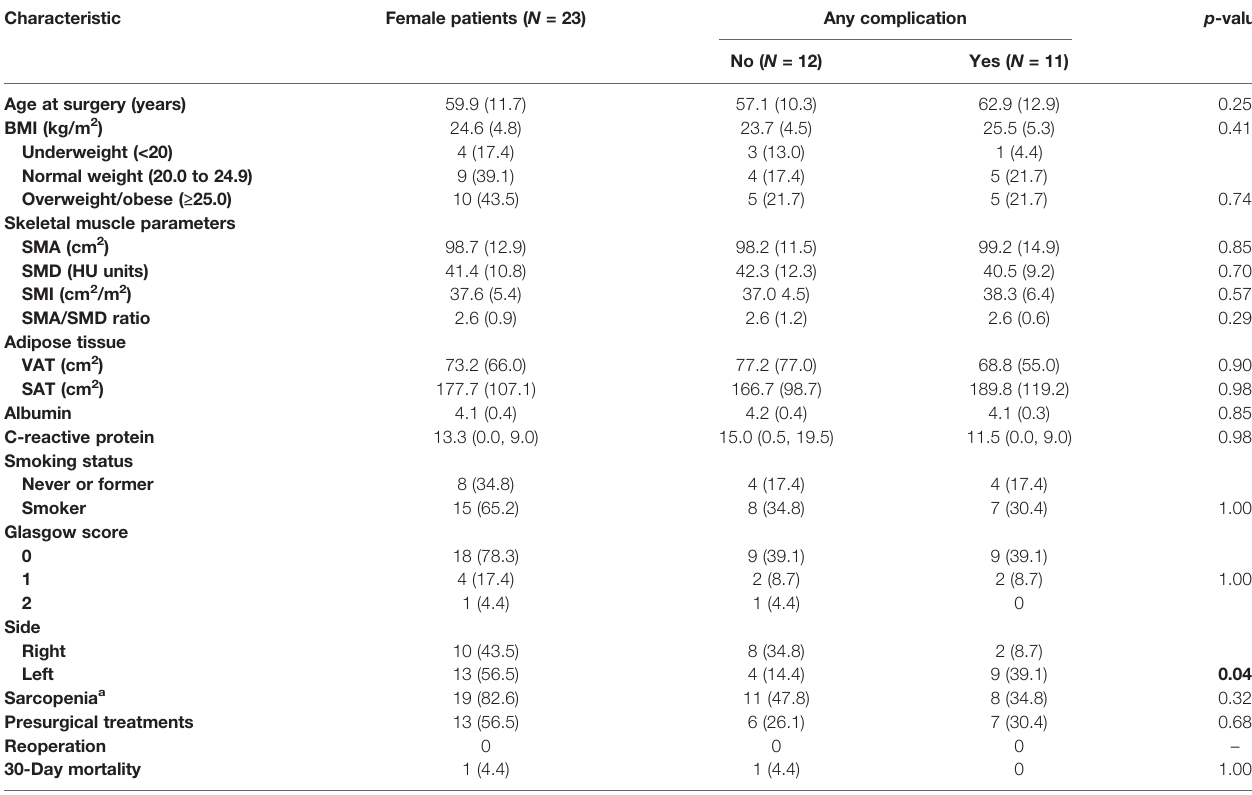
TABLE 4 | Patient characteristics and outcomes by complication (any) in female patients. Characteristic